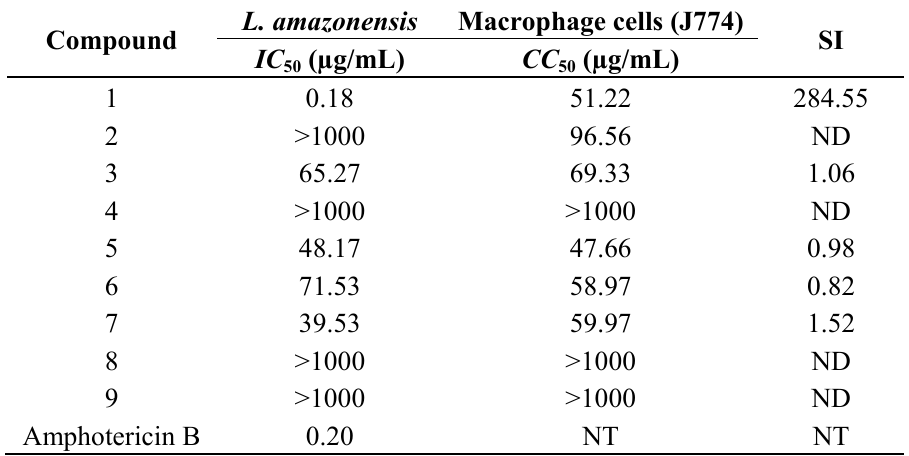
Table 1. Leishmanicidal activity of compounds 1 – 9 , against Leishmania